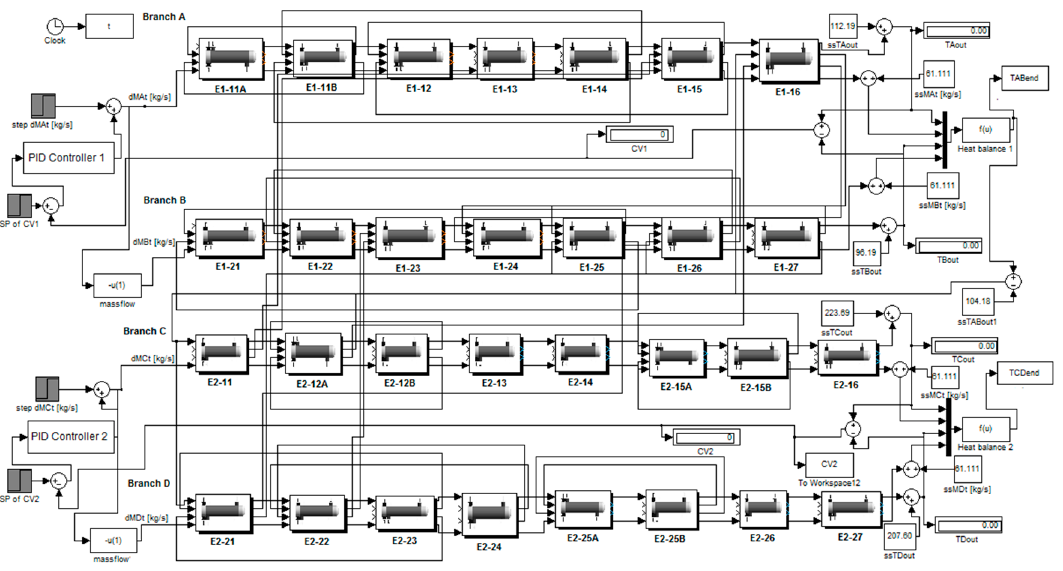
Figure 8. Scheme of the HEN with PID-control loops 1 and 2 implemented in Simulink/MATLAB.